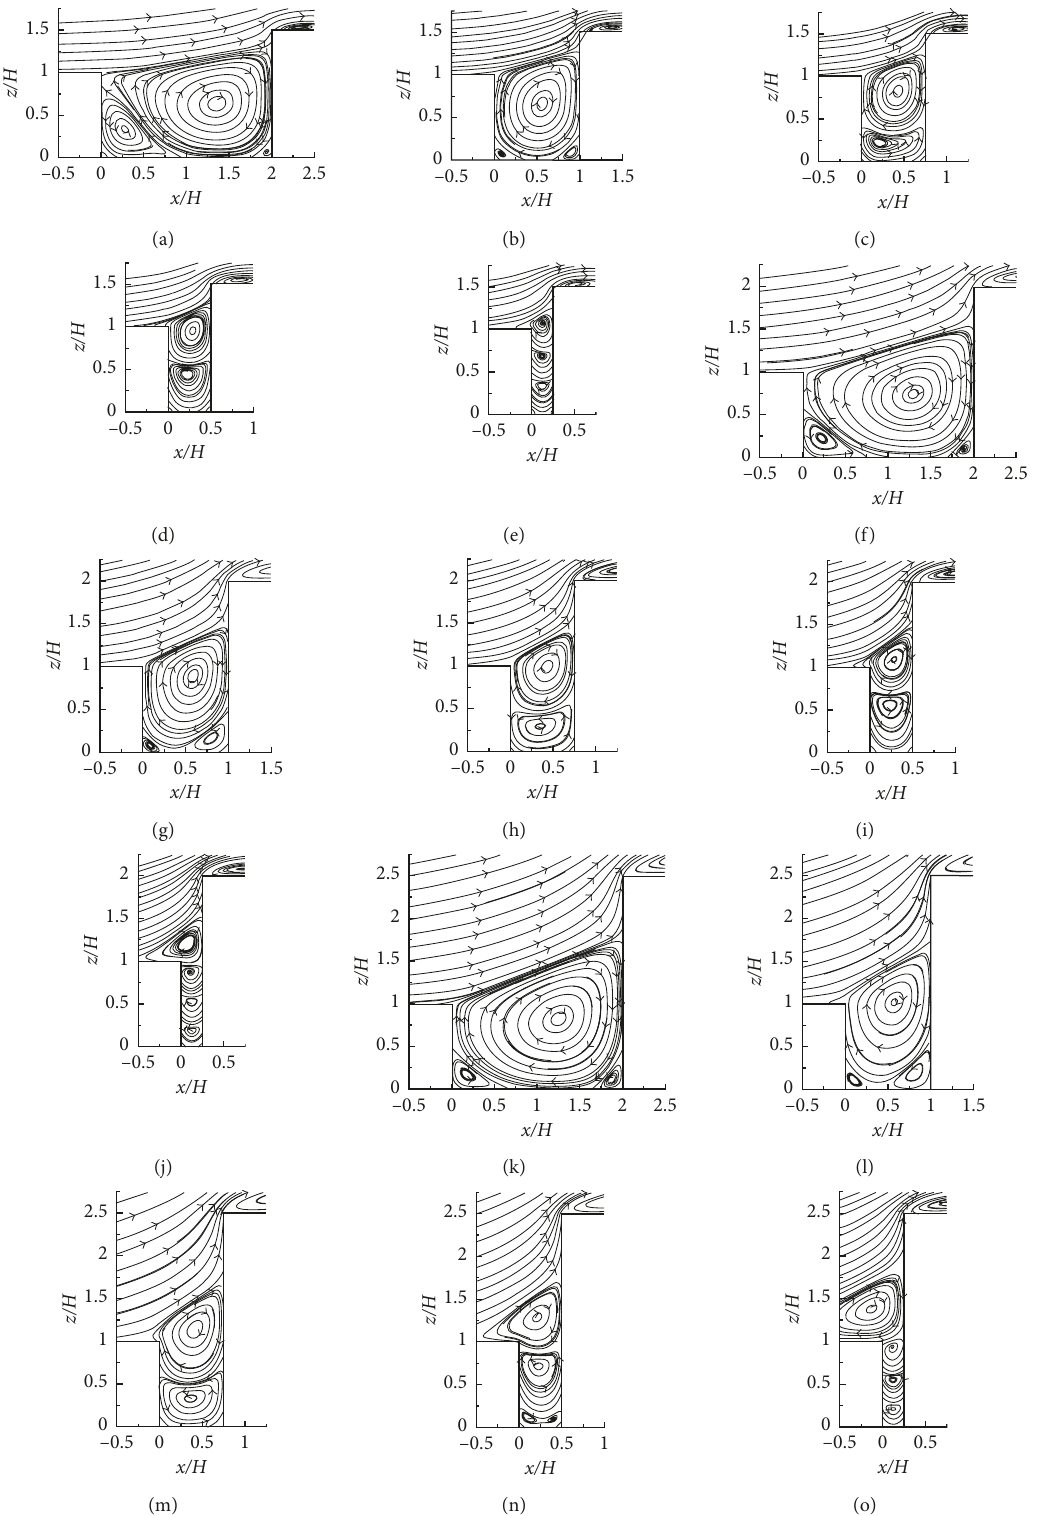
Figure 11: Streamlines of the simulated velocity magnitude V for AR AR 1 with H 2 / H 1 (cid:31) AR 2 with H 2 / H 1 (cid:31)